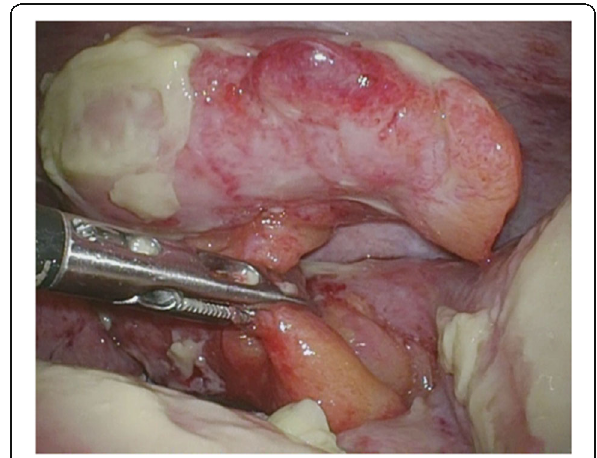
Fig. 2 Intraoperative findings of laparoscopic appendectomy. Swelling of the appendix and contaminated ascites were detected, but there was no evidence of appendiceal